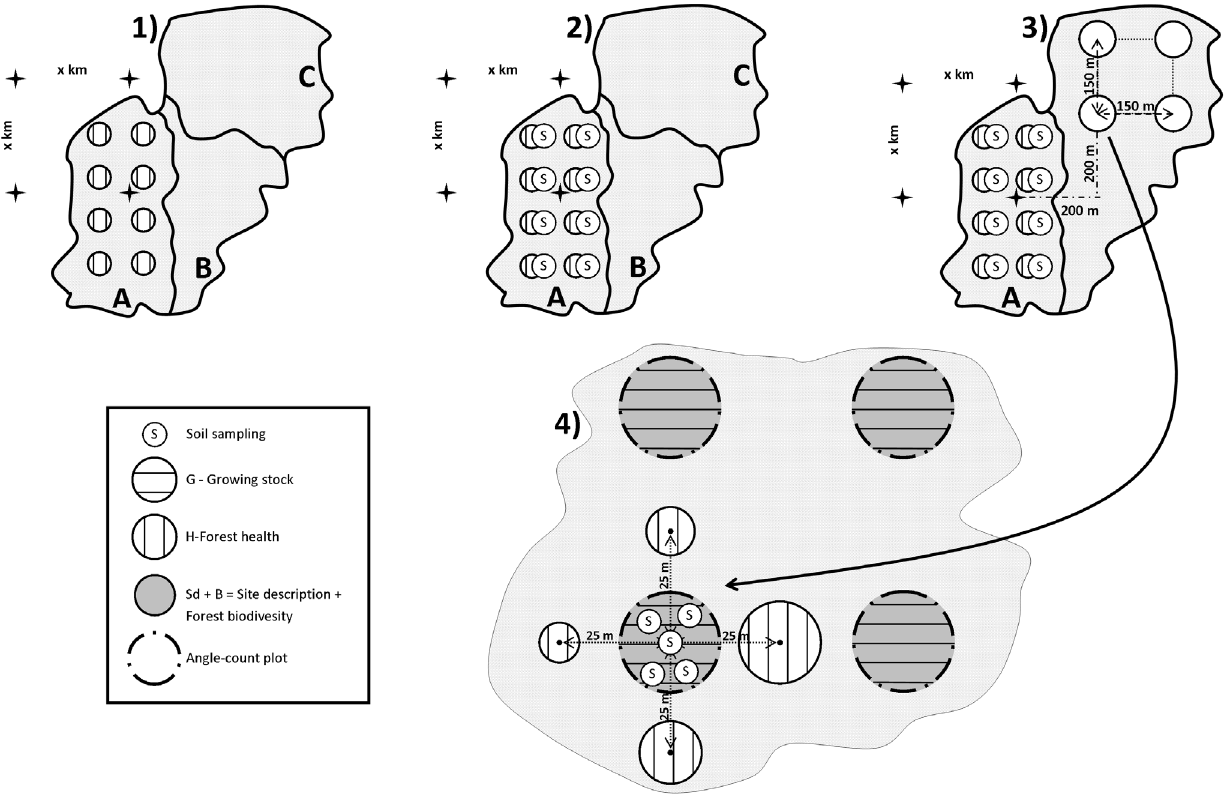
Figure 1. Historical development of Bavaria’s integrated forest resource inventory. 1) 1983–1985: National Forest Health inventory. The inventorying was performed in angle-count plots, evenly distributed across forest stands. 2) 1986: National Forest Health and Forest Soil Inventory. Soil plots, used for soil sampling, were distributed in parallel to the forest health plots. 3) 1986–2005. National Forest Inventory. The introduction of the NFI clusters, consisting of four angle-count plots, distributed across forest complexes. 4) 2006–2008. Integrated Forest Resource Inventory (IFRI). Forest soil sampling and forest health assessment, performed on the subsamples of the NFI/IFRI plots (southwestern plot on the 8 6 8 km grid), have become part of the inventory design. The majority of variables has been collected on the angle-count plots (NFI/IFRI plots), while forest health has been assessed on the 6-tree plots.